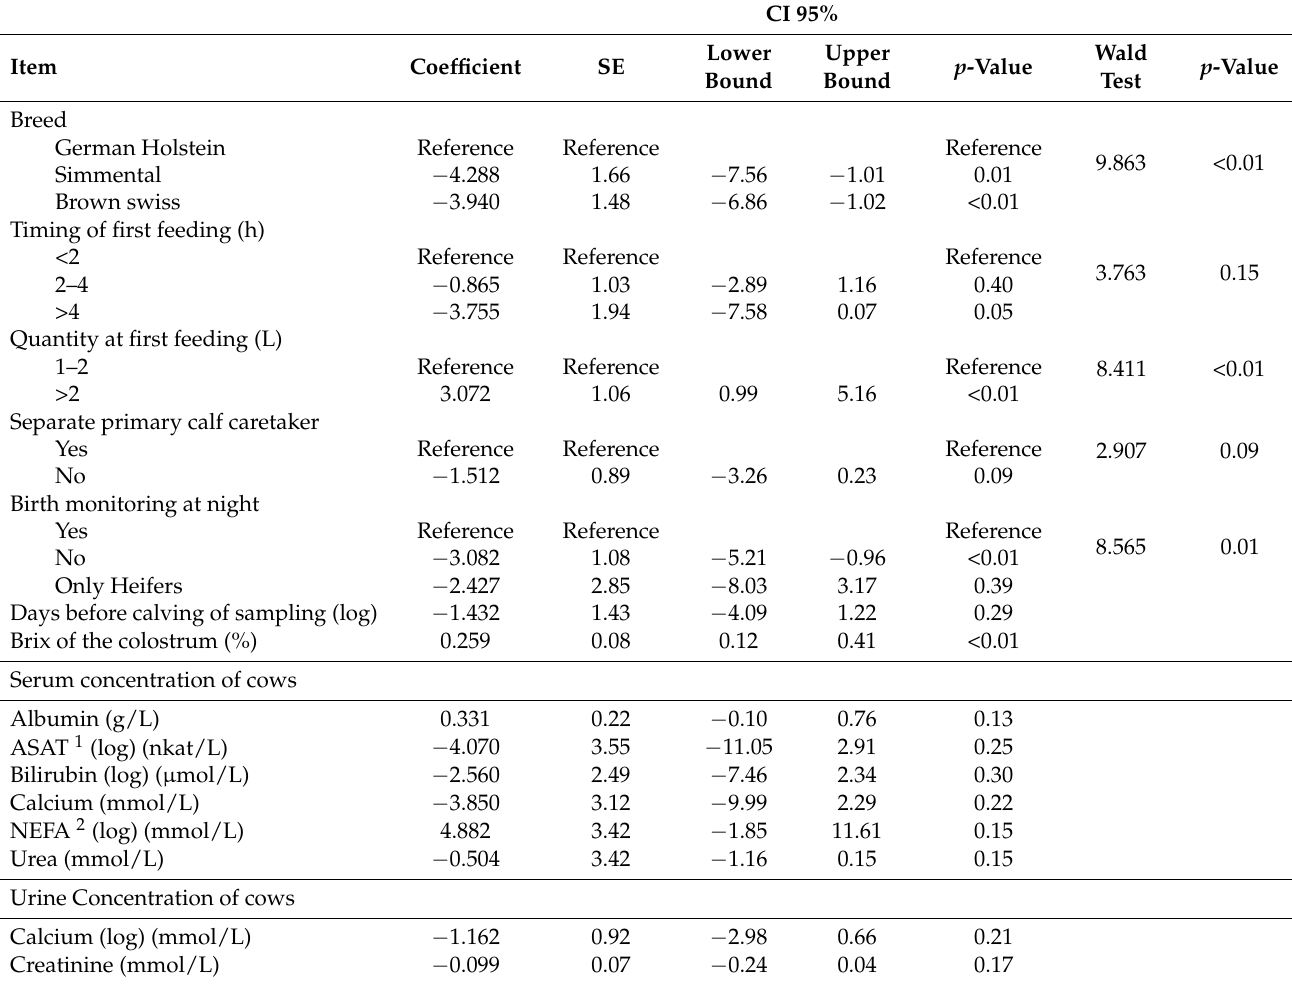
Table 4. Coefficients, SE and 95% CI of variables included in the final linear regression model regarding the association between serum total protein concentration of 511 calves between March 2017 and March 2018 and cow-level variables measured 1 to 3 weeks before calving, including Brix values of colostrum samples. CI 95%